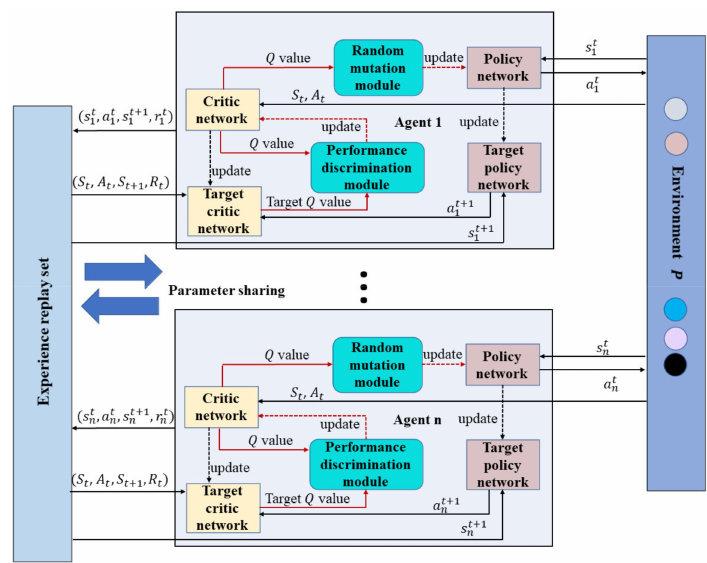
Figure 1. MPT-NCE